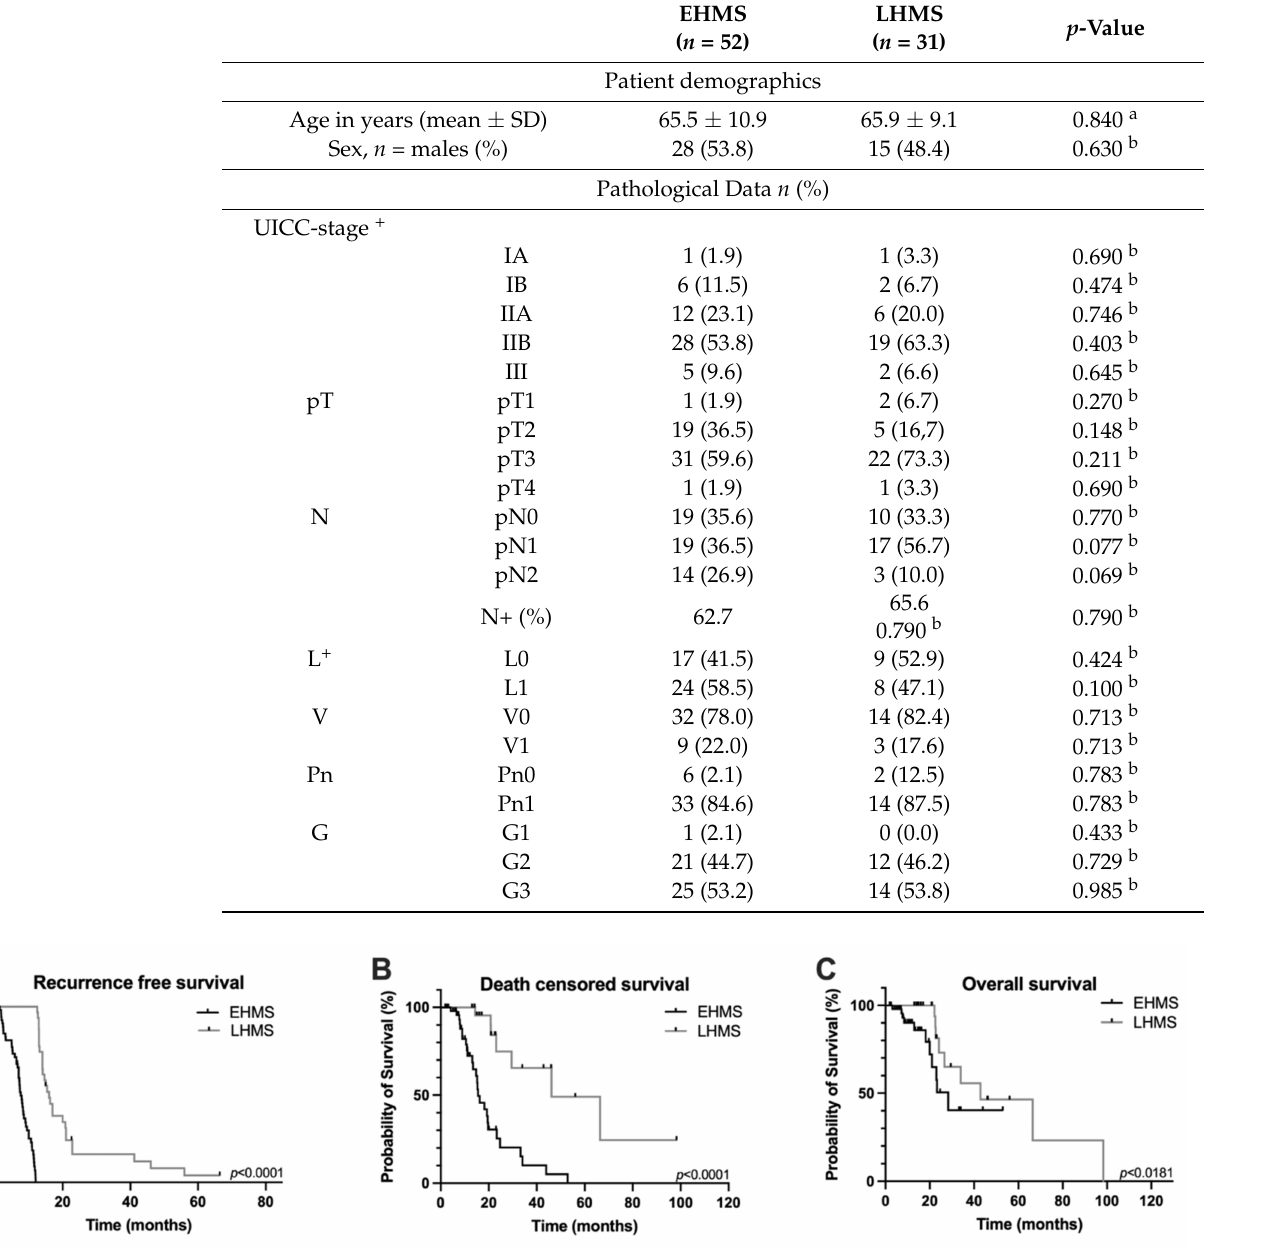
Figure 2. Kaplan–Meier survival curves of PDAC patients included in the study. Recurrence-free survival ( A ), death censored survival ( B ) and overall survival ( C ) were significantly poorer in PDAC patients with early hepatic metastatic spread (EHMS) ( n = 52) compared to patients with late hepatic metastatic spread (LHMS) ( n = 31). Statistically significant p -values are indicated in the